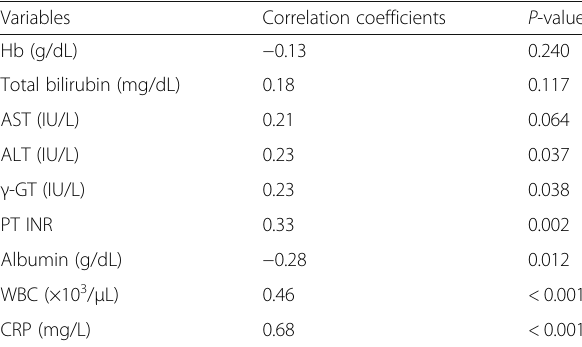
Table 4 Correlation between serum ferritin and biochemical factors ( n = 80) Variables Correlation coefficients